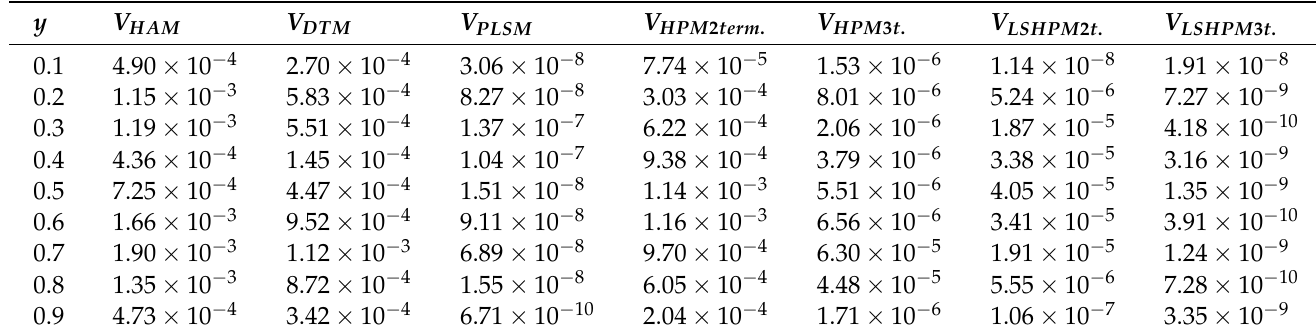
Table 4. Comparison of the absolute errors of the approximate solutions for V for the case Re = 1 and Ha =